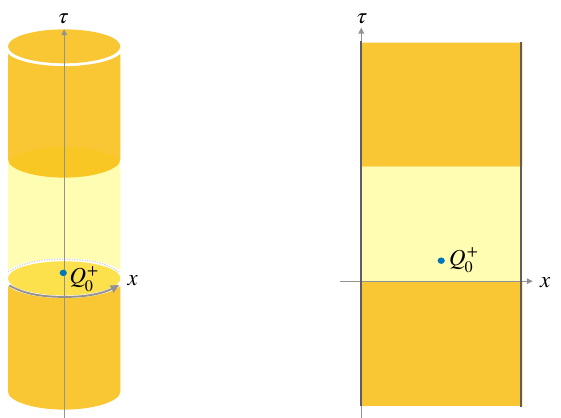
Figure 4: Path integral geometries corresponding to the massless quench in finite system size: PBC give rise to the cylinder geometry on the left, while OBC to the strip geometry on the